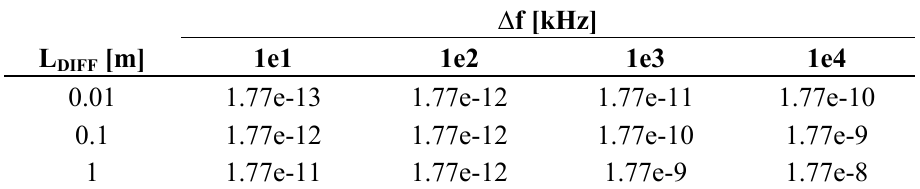
Table 6. Exemplary computed RMS length noise ([m]) dependency on interferometer paths differences and the frequency noise of the